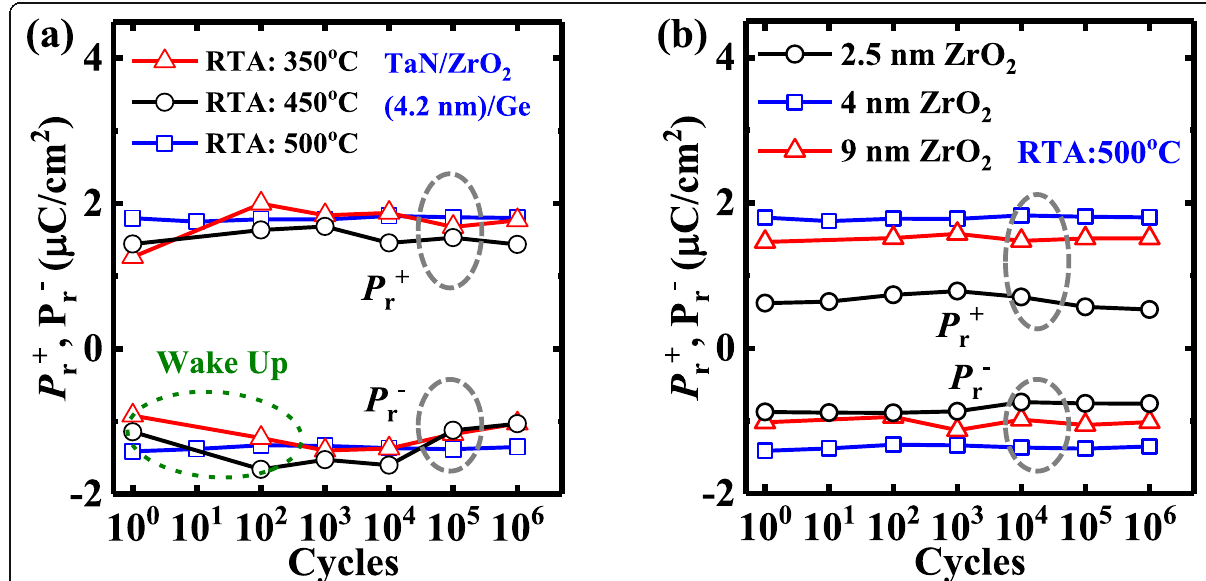
Fig. 4 a P r vs. the number of ms-pulse sweeping cycles for 4 nm ZrO 2 capacitors with different RTA temperatures. b P r vs. number of ms-pulse sweeping cycles for the ZrO 2 capacitors after annealing at 500